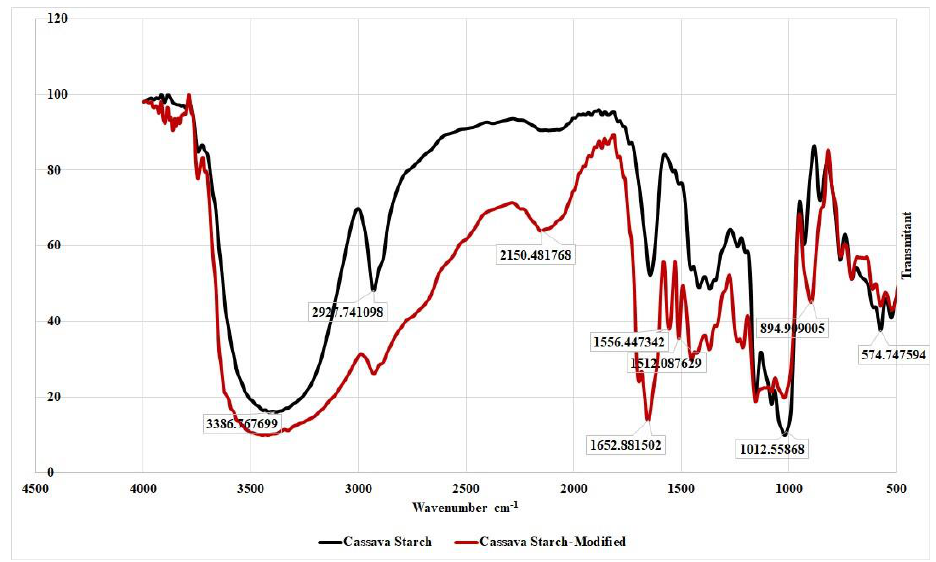
Figure 5. Fouried transform infrared spectroscopy (FTIR) spectrum of cassava starch and cassava starch modified by sodium tripolyphosphate (STPP).